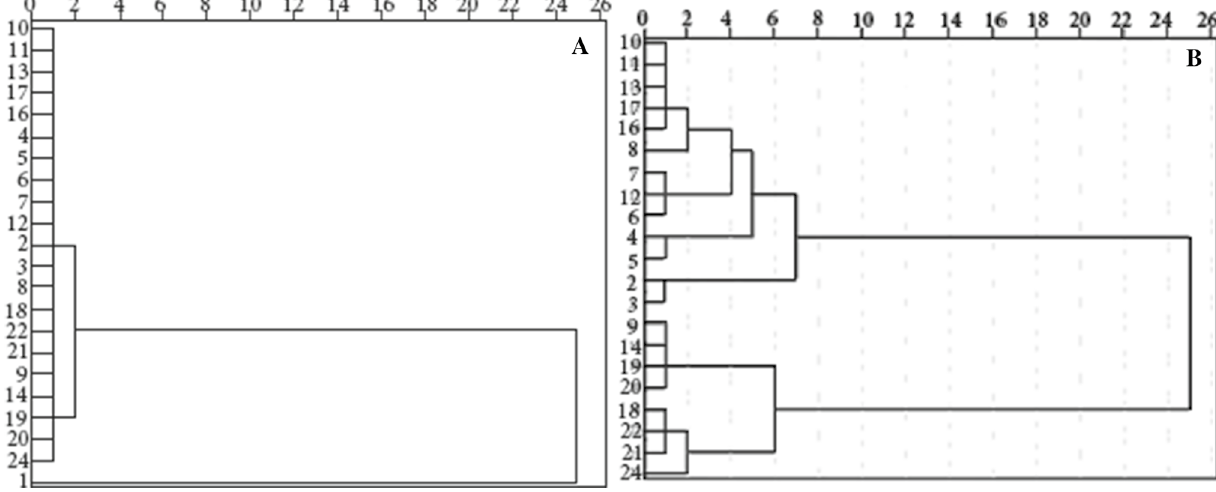
Fig. 7 Dendrogram of sampling stations in the lake and downstream of the Gotvand-e-Olya Dam; a nearest neighbor method and b wards method (the second-time